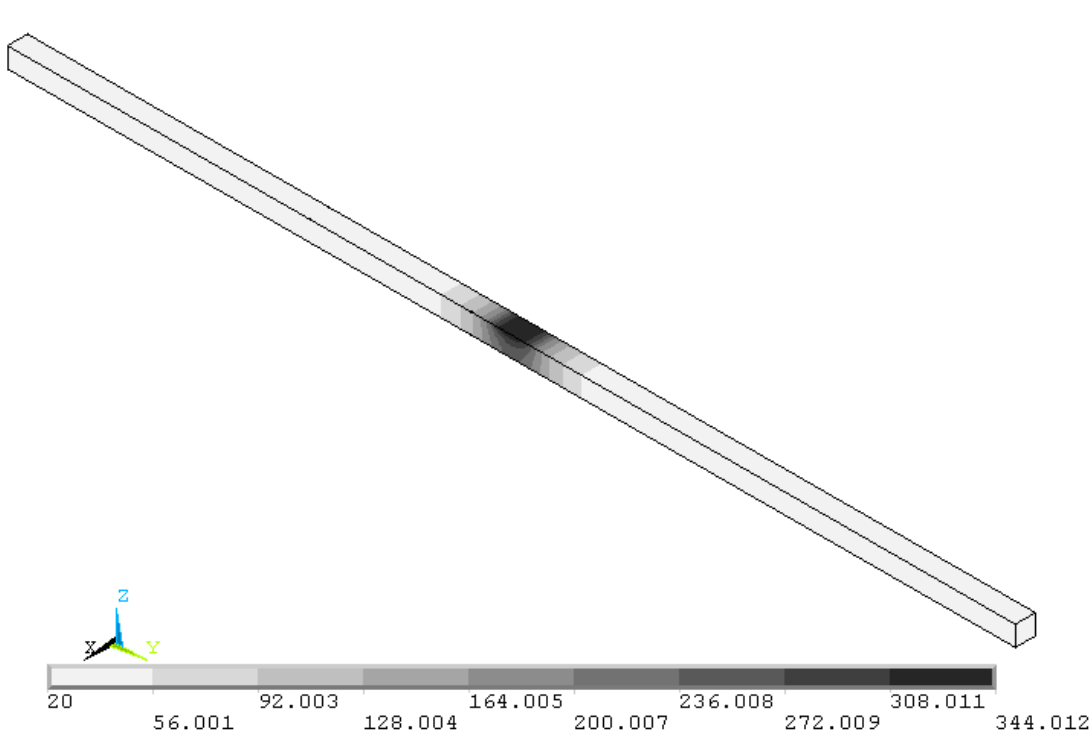
Figure 2. Temperature distribution at t = 1 s.